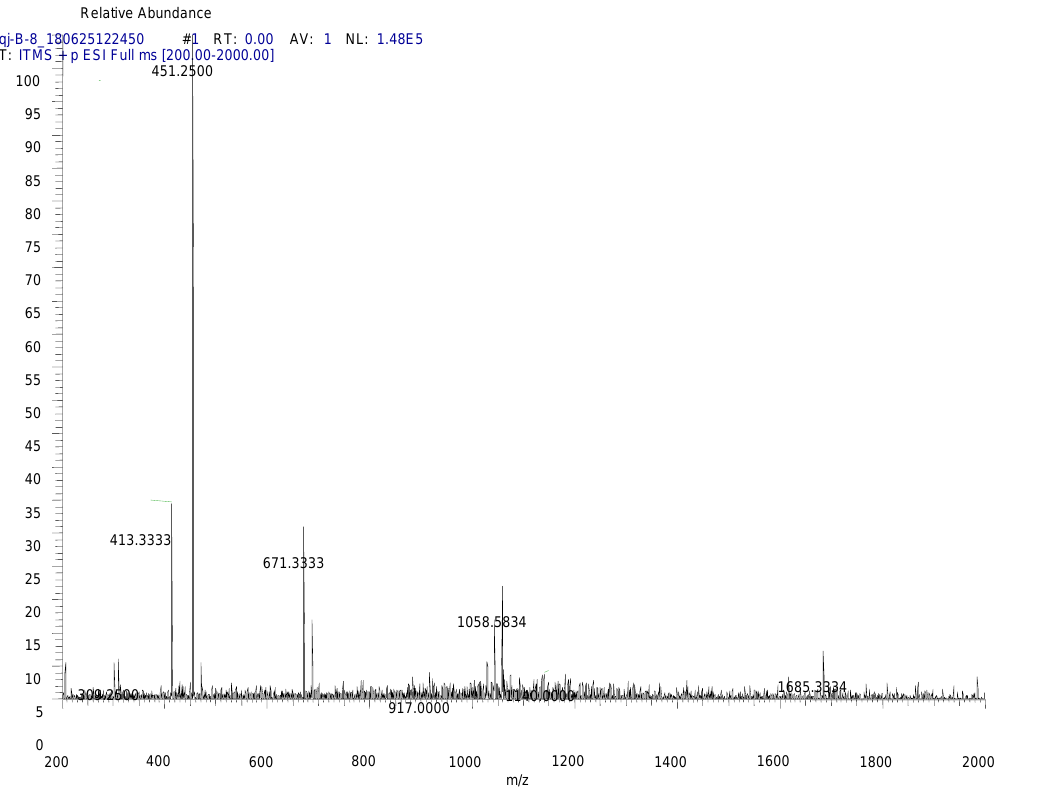
Figure A5. ( a ) 1 HNMR spectrum of compound 4 . ( b ) 13 CAPT spectrum of compound 4 . ( c ) HSQC spectrum of compound 4 . ( d ) HMBC spectrum of compound 4 . ( e ) ESIMS spectrum of compound 4 .